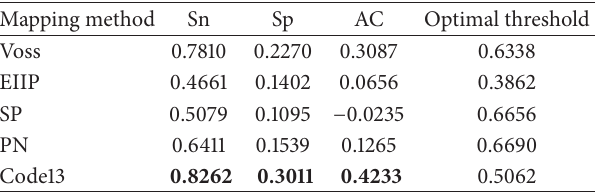
Table 1: Performance measures of five mapping methods for sequence F56F11.4 based on Marple-WPT